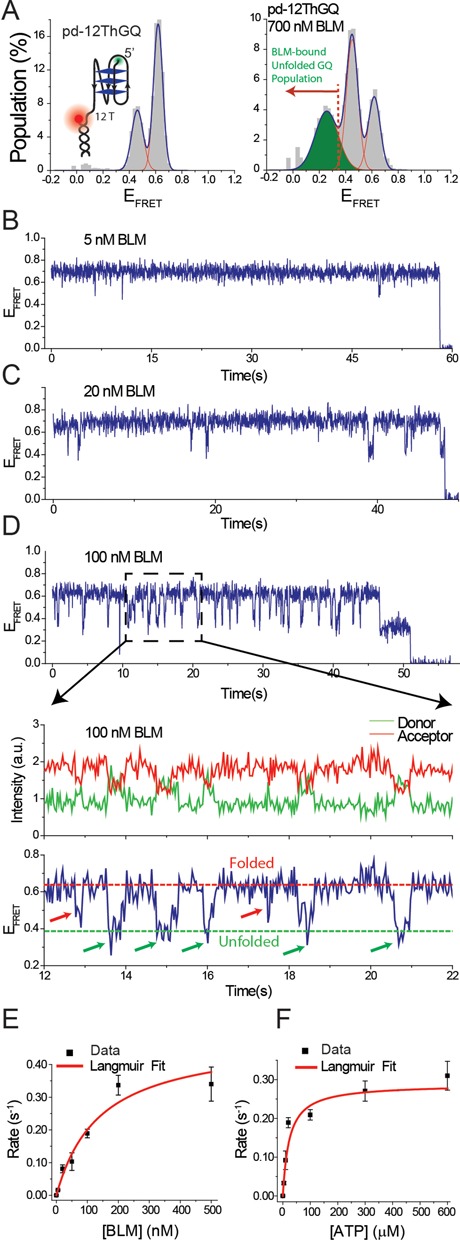
(A) (Left Panel) smFRET histogram of pd-12ThGQ construct at 150 mM K+. The inset shows a schematic of this construct. (Right Panel) smFRET histogram of pd-12ThGQ when 700 nM BLM is added to the chamber in the absence of ATP. The newly emerging low-FRET peak represents the BLM-bound unfolded GQ state (green peak). The red dashed line and the red arrow indicate the threshold EFRET that is used to identify successful GQ unfolding events by BLM. (B–D) smFRET time traces for pd-12ThGQ construct at 20 μM ATP and (B) 5 nM BLM; (C) 20 nM BLM; (D) 100 nM BLM. The bottom panel in (D) shows a zoomed-in version of a shorter time interval that illustrates the details of the dynamics of the system. The folded and unfolded GQ FRET levels are marked with dashed lines. Five successful GQ unfolding events (marked with green arrows) and two unsuccessful attempts (marked with red arrows) are indicated on the smFRET trace. (E) Event rate as a function of BLM concentration at 20 μM ATP. (F) Event rate as a function of ATP concentration at 20 nM BLM. The red curves in (E) and (F) are Langmuir binding isotherm fits to the data. The error bars for the event rates in (E) and (F) are determined by dividing the complete data set into three and finding the standard deviation of the mean values of these three data sets.